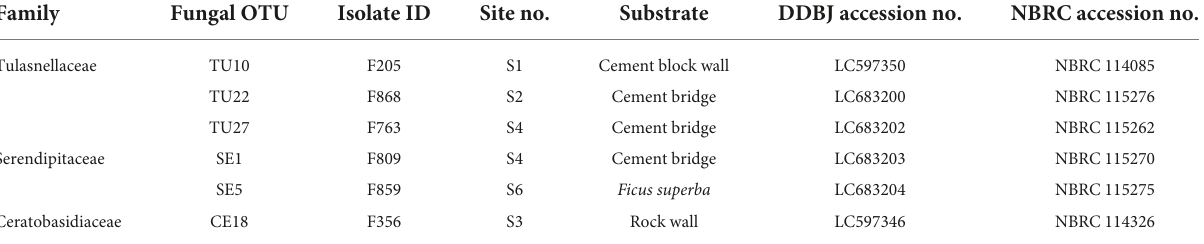
TABLE 2 Fungal isolates from Dendrobium officinale used for symbiotic culture. Family Fungal OTU Isolate ID Site